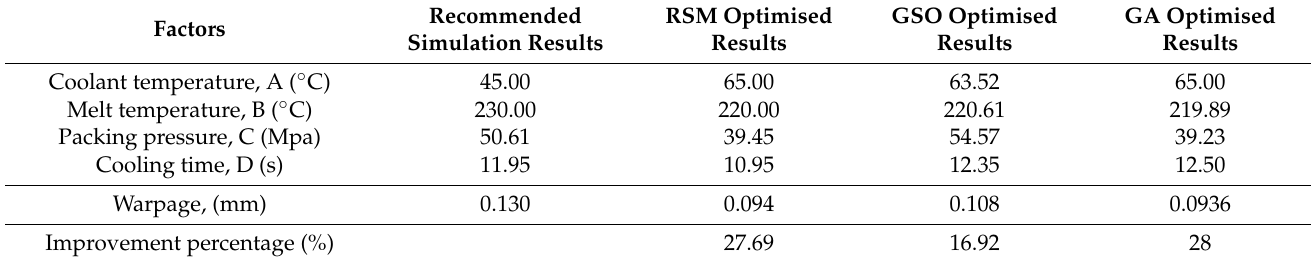
Table 7. Recommended simulation results versus optimised results using RSM, GSO and GA for MGSS conformal cooling channels.